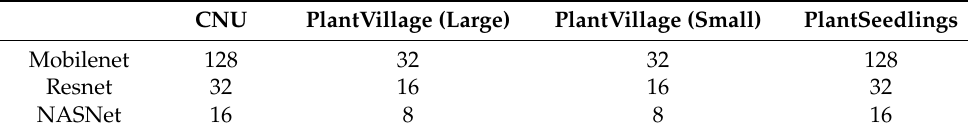
Table 1. Batch size according to model and dataset.